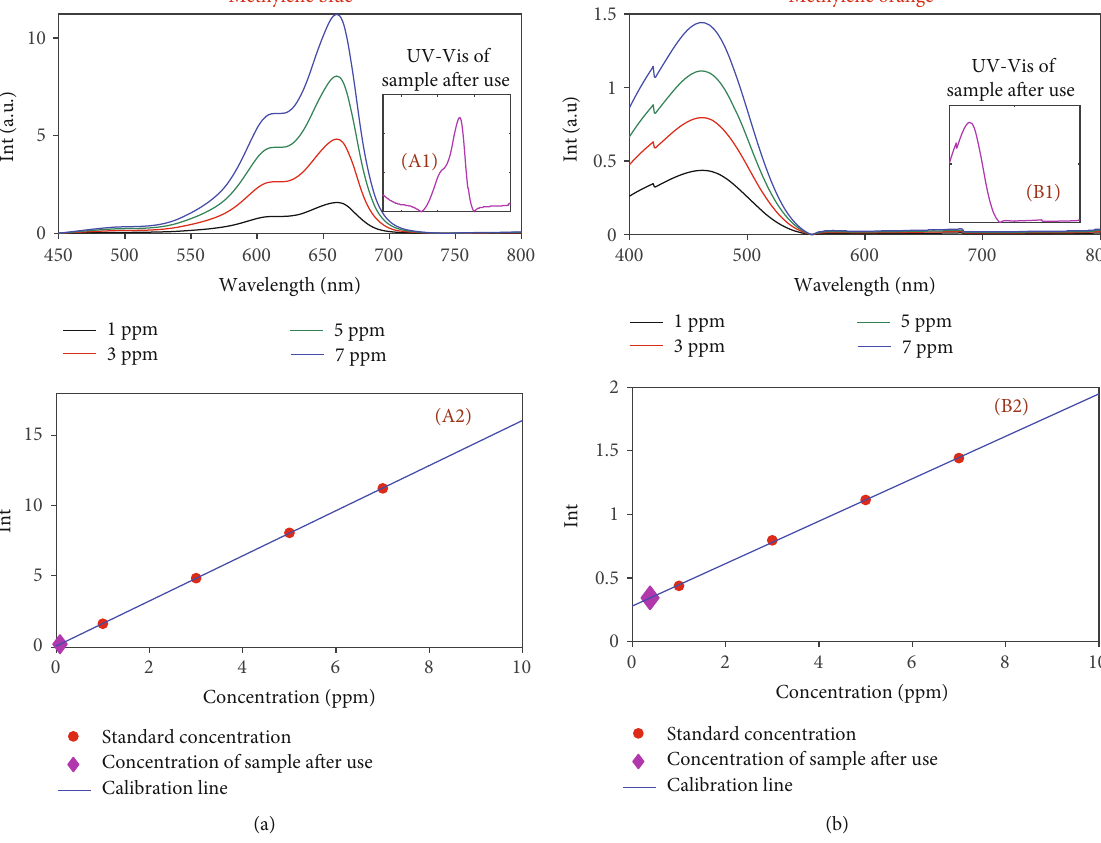
Figure 5: The UV-Vis spectra of (a) MB and (b) MO. The UV-Vis spectra of (a1) MB and (b1) MO after interaction with the sensing layer. The calibration curve for (a2) MB and (b2)